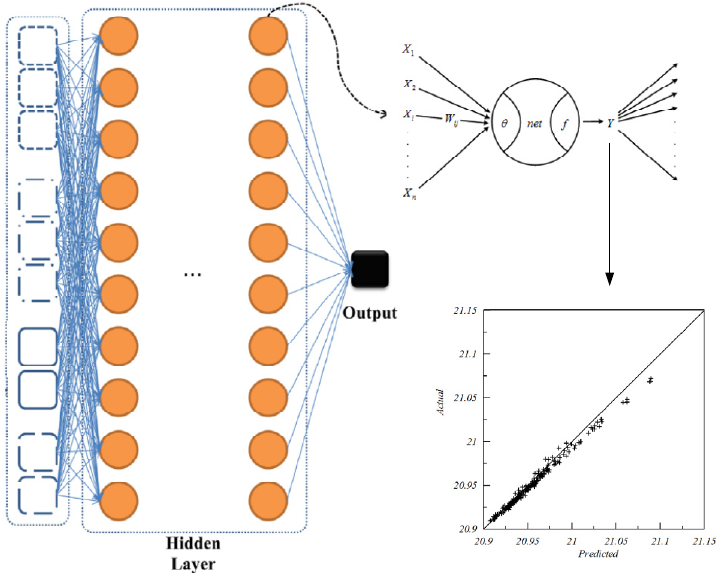
Figure 2. The convolutional neural network (CNN) model for prediction.